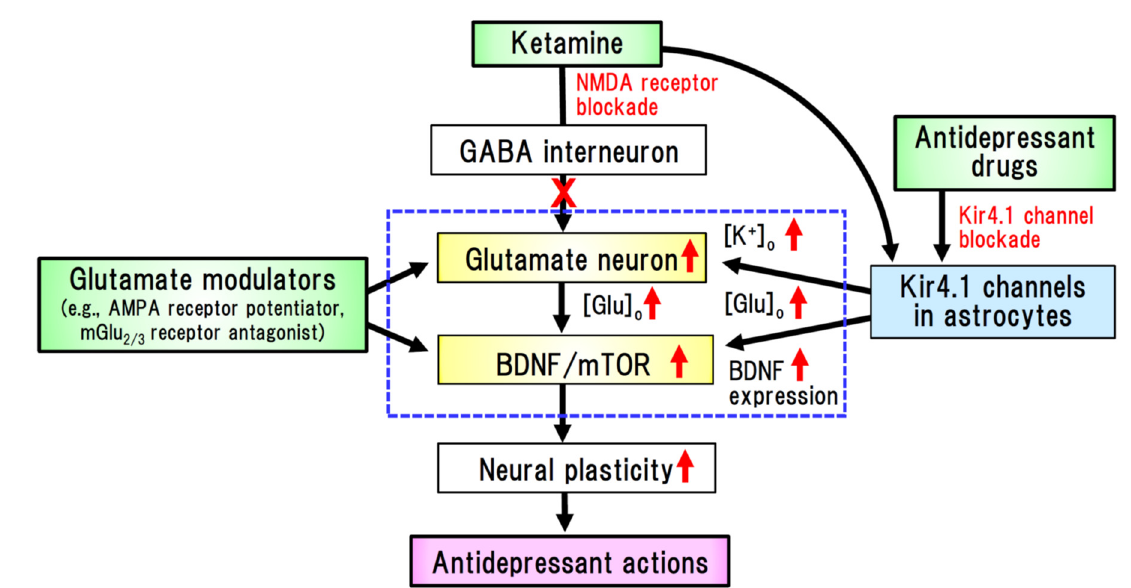
Figure 3. New medications for the treatment of major depressive disorders (MDD) based on the glutamate–BDNF hypothesis. Ketamine is known as a rapid-acting antidepressant drug with clinically proved efficacy, the activity of which is believed to be associated with the glutamate–BDNF–mTOR system. Ketamine inhibits NMDA receptors in GABA interneurons, which in turn activates glutamatergic neurons and elevates extracellular levels of glutamate. Glutamatergic neuron activation facilitates neural plasticity and alleviates morphological changes in the brain of MDD patients. This drug also induces the expression of BDNF in astrocytes via its interaction with Kir4.1 channels or a non-NMDA mechanism (e.g., Gs-cAMP signaling). Kir4.1 channel inhibitors presumably have mechanisms of action similar to those of ketamine, promoting the elevation of extracellular glutamate and inducing BDNF expression. Glutamate modulators, such as AMPA receptor potentiators and presynaptic mGlu 2/3 receptor antagonists, similarly mimic the action of ketamine via activating glutamatergic neurons.